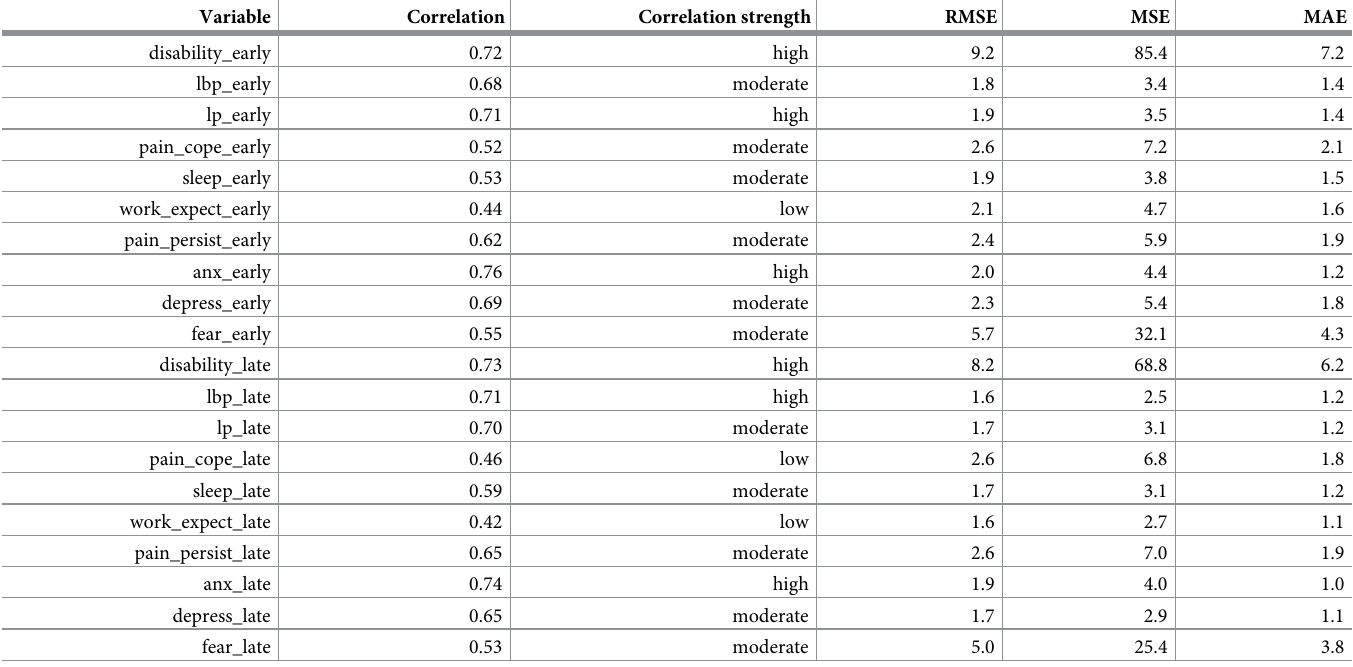
Table 2. Measurement errors between observed and predicted change values.